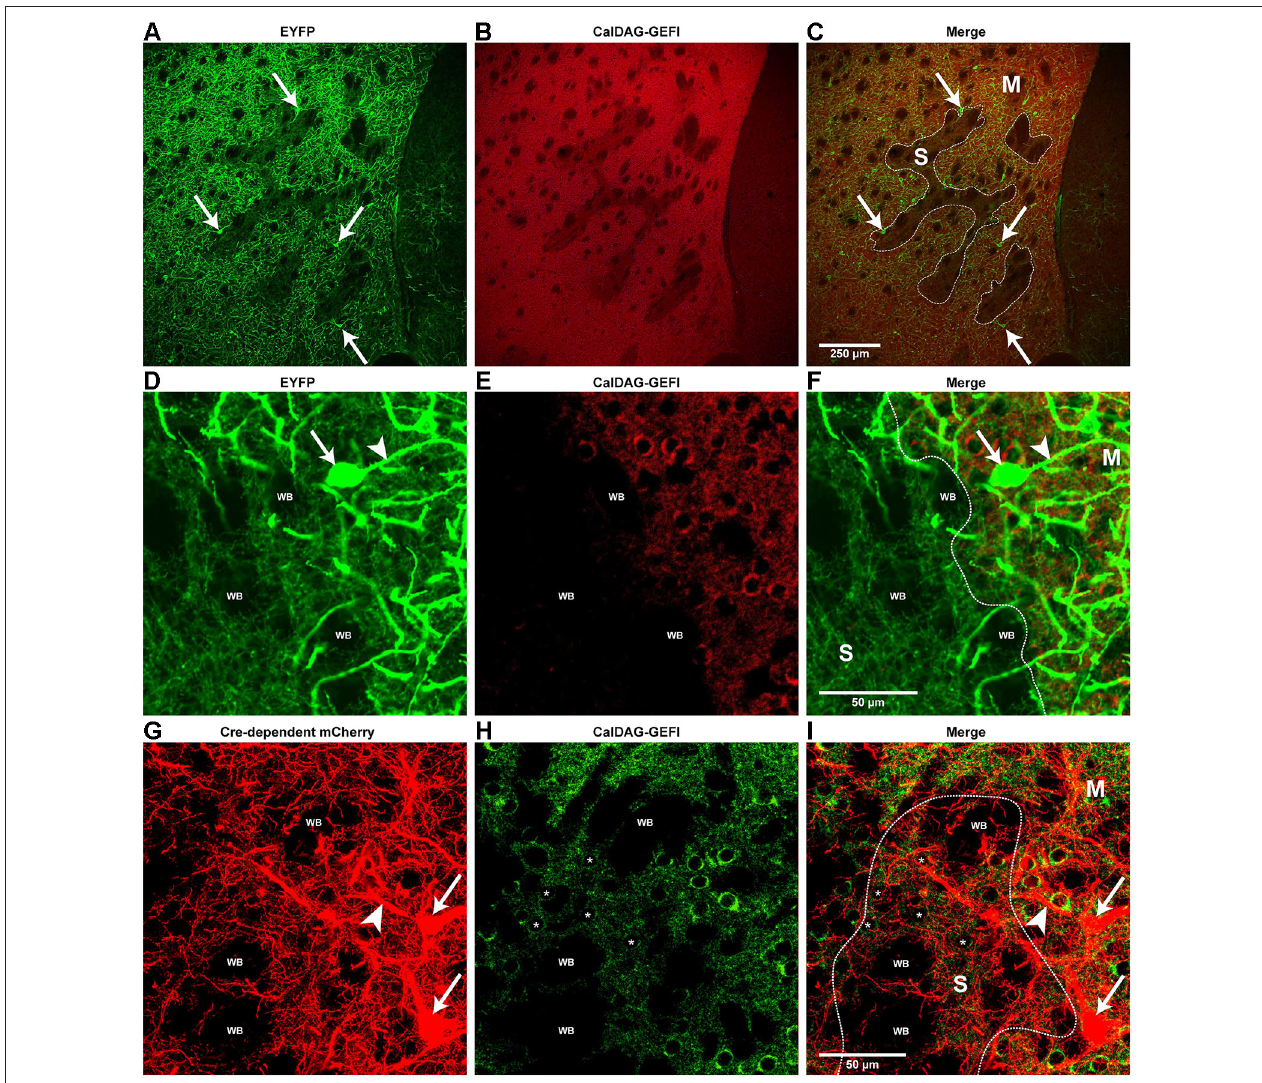
cholinergic axons, appear equally abundant in both striosomes (left half of panels) and matrix. (G–I) High-magnification confocal images of the dorsal striatum from a ChAT-Cre knock-in mouse with Cre-dependent mCherry (red fluorescence) to label cholinergic interneurons (arrows in G and I ). CalDAG-GEFI immunofluorescence (green) defines the matrix compartment. The medium-sized cell bodies with low CalDAG-GEFI immunoreactivity (asterisks in the nuclei of example striosome cells in H and I ) are within a striosome (approximate border outlined in white). Thick cholinergic cell processes (arrowhead in G and I ) are abundant in the matrix and fine processes with varicosities are dense in both the matrix and striosomes. S: striosome; M: matrix; WB: White matter